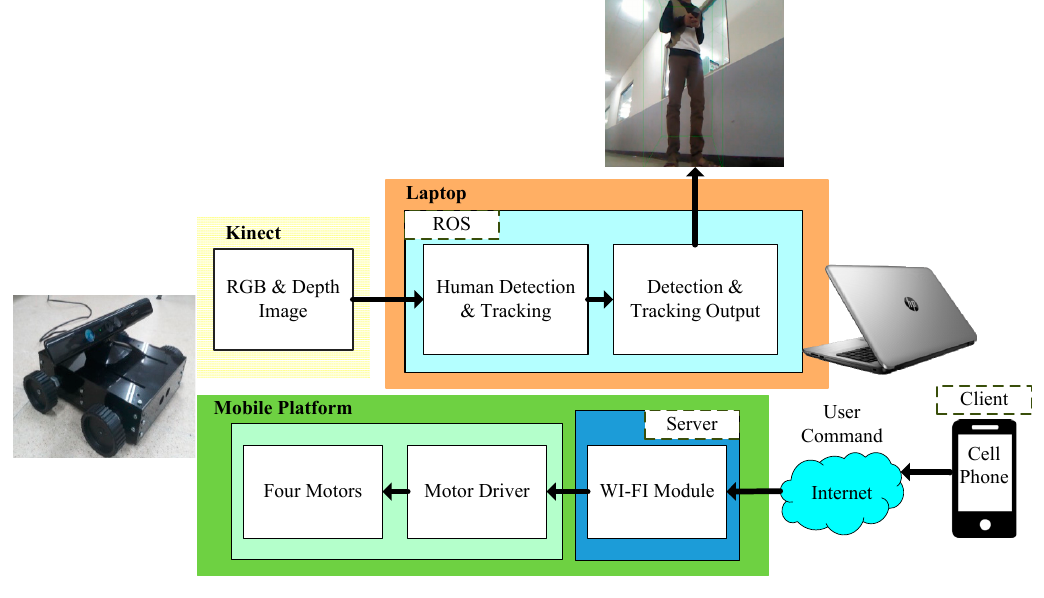
Figure 1. System Architecture.